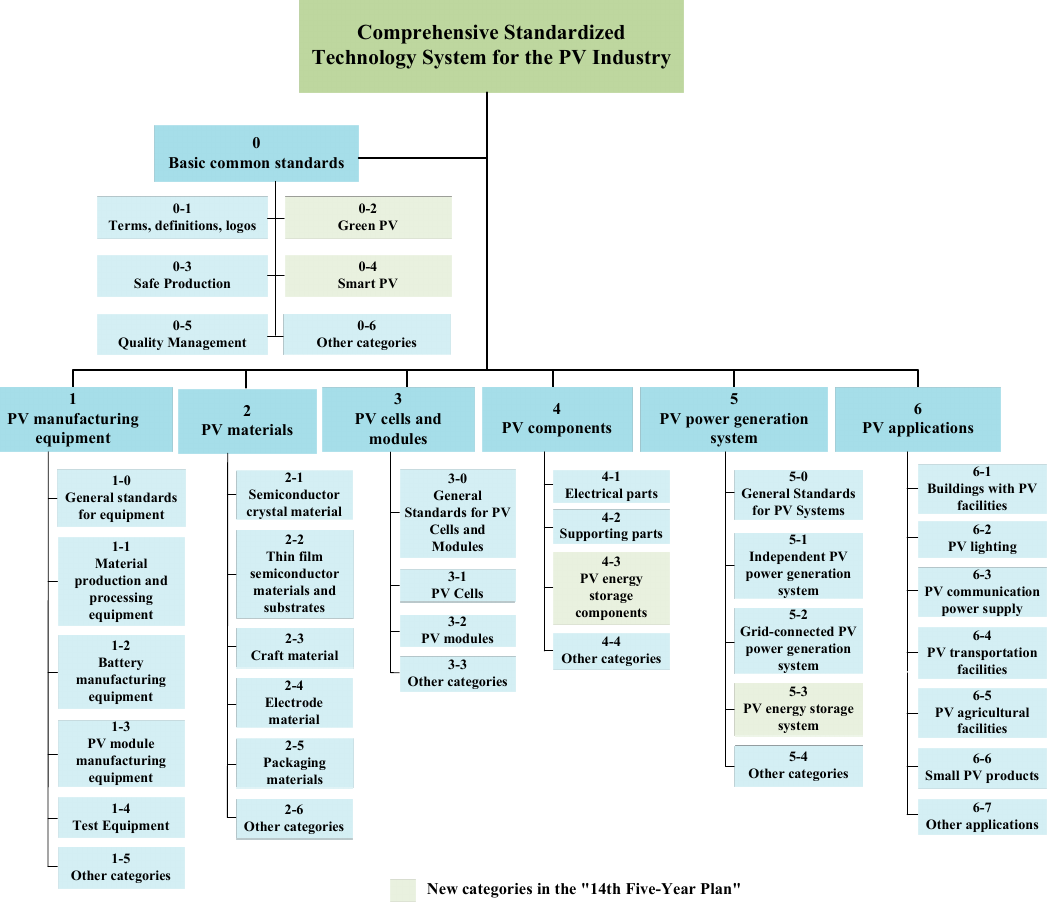
Figure 6. “14th Five-Year Plan” Photovoltaic Industry Comprehensive Standardization Technical System Framework Diagram.